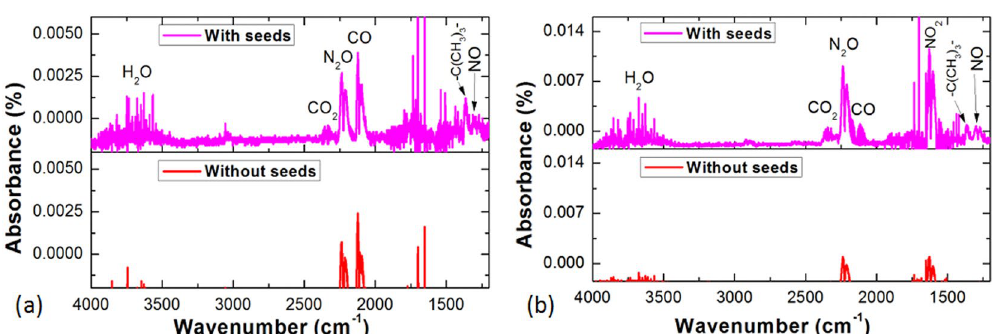
Figure 4. FTIR spectra of the exhaust gas for ( a ) air and ( b ) N 2 discharges with and without seeds. In addition to nitrogen oxides, water gas, CO 2 , CO and the − C(CH 3 ) 3 − group were observed in the FTIR spectra for both air and N 2 flow discharges in the presence of cotton seeds, which confirms plasma chemical etching of the seed surface via oxidation of organic components present on the seed